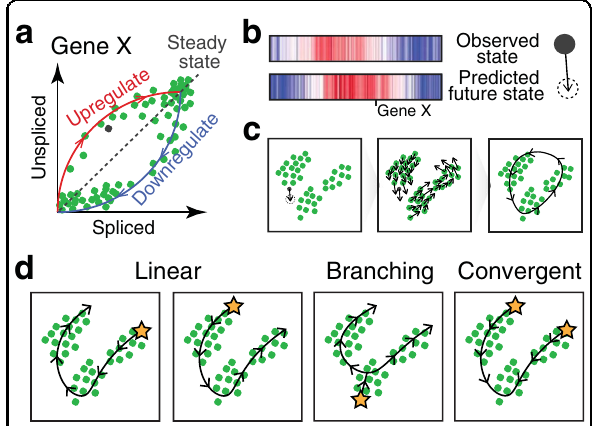
Fig. 6 Trajectory inference combined with RNA velocity analysis. a Transcriptional dynamics model used to estimate RNA velocity. For an individual gene such as Gene X, RNA velocity is modeled across a population of cells based on the observed spliced (e.g., exonic) and unspliced (e.g., intronic) mRNA abundances, plotted on the x - and y -axes, respectively. In this model, cells, illustrated as points, upregulating expression of the gene are expected to exhibit a relatively higher proportion of unspliced mRNA compared to spliced mRNA, while cells downregulating expression of the gene are expected to exhibit a relatively lower proportion of unspliced mRNA compared to spliced mRNA. b Such models of transcriptional dynamics can be used to extrapolate expression levels for many genes at a future time point. In this illustration, the current high-dimensional observed transcriptional state for a cell is visualized in a heatmap in which each column represents a gene, where red indicates higher expression, and blue indicates lower expression. The predicted future transcriptional state for the same set of genes based on the RNA velocity model is shown below. c The future transcriptional state for each cell, as predicted by the RNA velocity models, can be projected to a lower-dimensional embedding (e.g., tSNE and PCA). An arrow can be used to connect the observed transcriptional state and the future predicted transcriptional state in the lower-dimensional embedding to visualize velocities. This can be performed for each cell individually, as a gridded velocity fi eld, or as a single directed principal curve, as illustrated. d RNA velocity analysis may be applied to distinguish between different trajectory patterns, such as a linear progression through different states, versus branching or convergent trajectories, as illustrated. RNA velocity analysis may also be applied to identify the roots or origins of cellular trajectories, illustrated here as